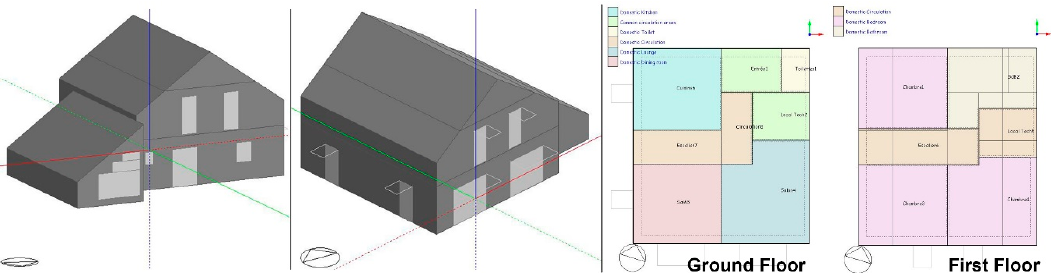
Figure 4. Multizone building energy model in DesignBuilder [20].